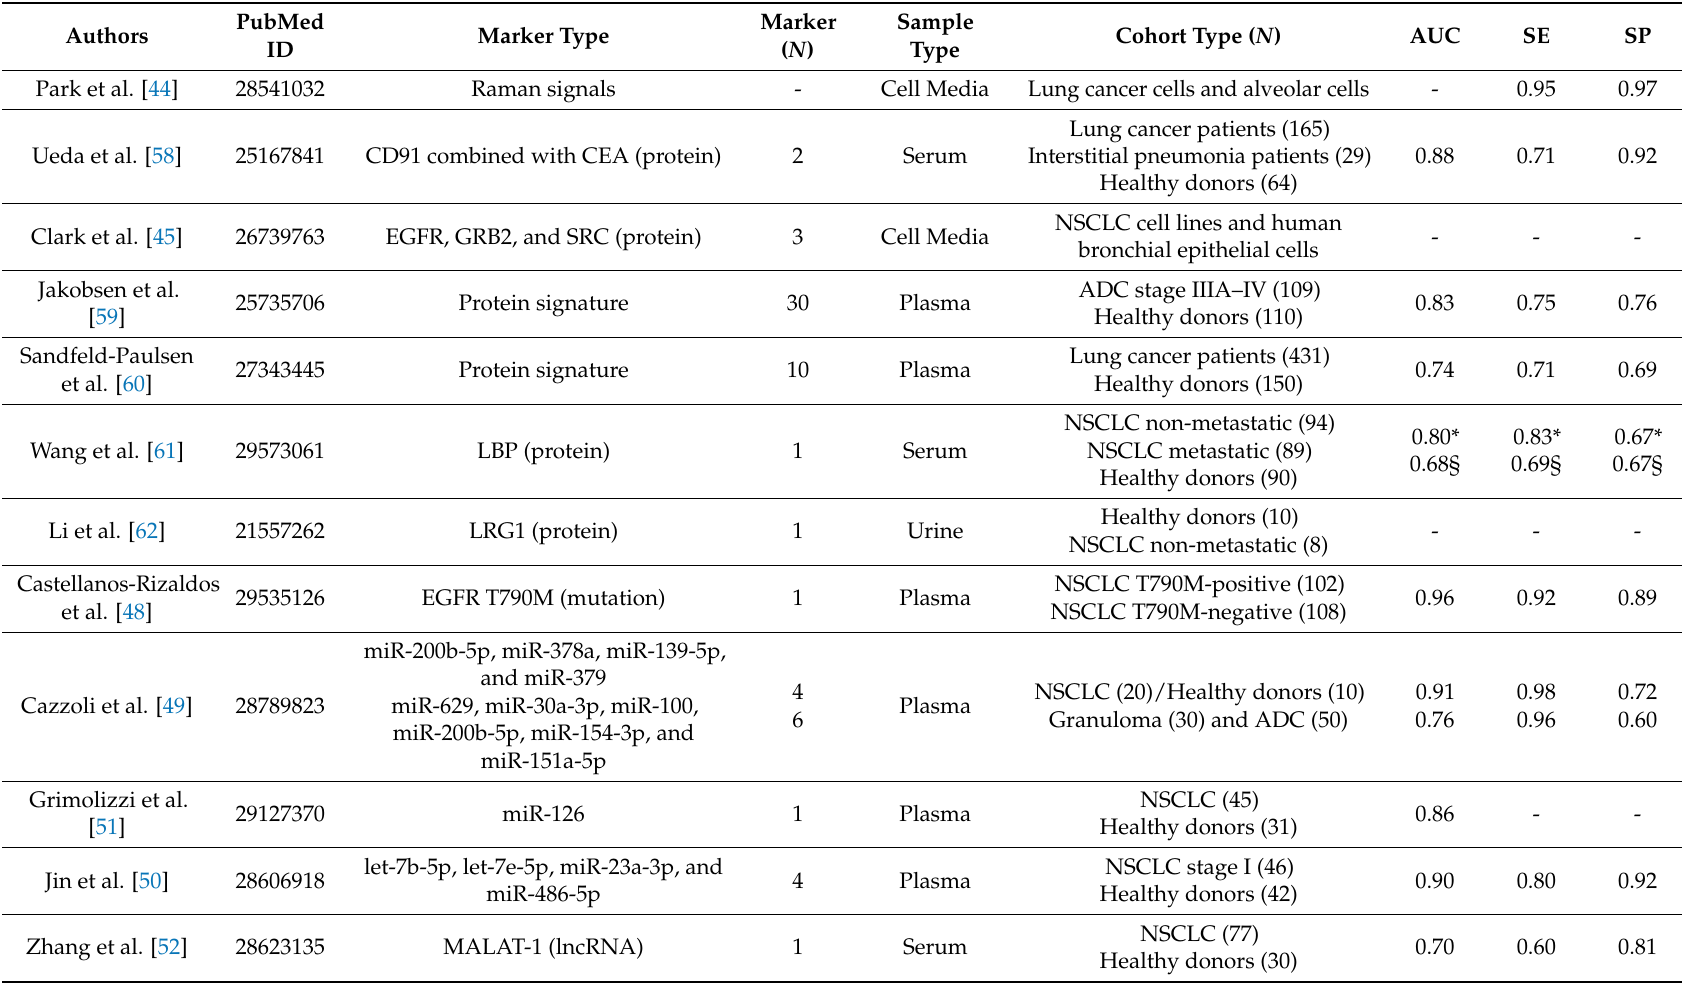
Table 2. TEX biomarkers diagnostic in lung